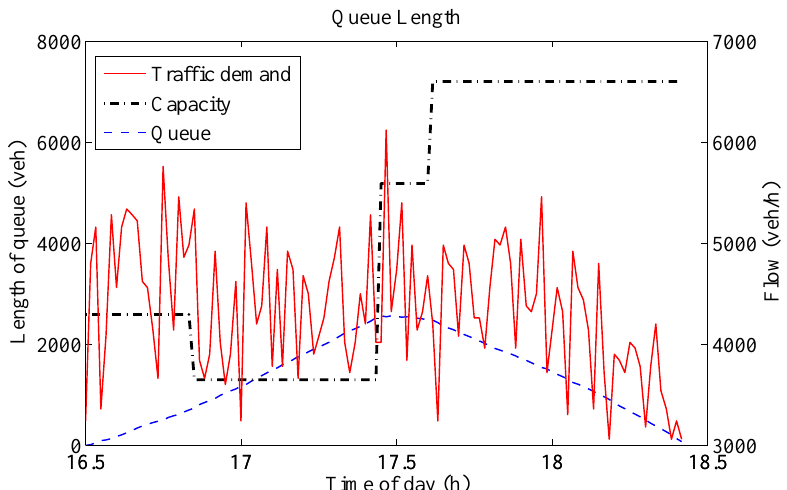
Figure 6. The length of a queue for a fictitious incident